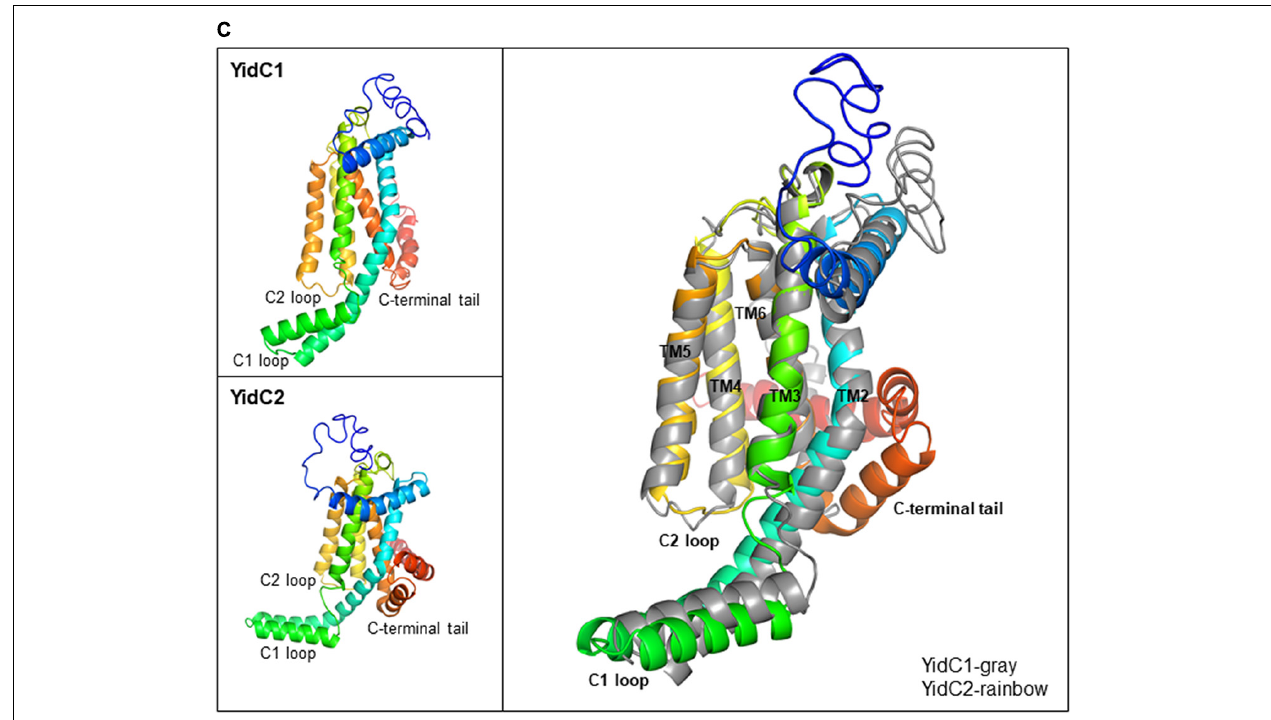
FIGURE 1 | In silico comparison of S. mutans YidC1 and YidC2. (A) Predicted membrane topologies of YidC1 and YidC2 using TM-Pred [TMpred Server (vital-it.ch)]. The mature YidC1 and YidC2 proteins each contain five TM domains and three cytoplasmic regions: C1 loop, C2 loop, and C-terminal tail. “ + + + ” or “ + + + + + ” refers to the relative positivity of the charged C-terminal tails of Sm YidC1 and YidC2. (B) Alignment of primary and secondary structures of SmYidC1 and SmYidC2 predicted by I-TASSER [I-TASSER server for protein structure and function prediction (umich.edu)]. Amino acid sequences were aligned using the Clustal Omega Program (EMBOSS-Needle) and presented using the ESPript2.2 program (Gouet et al., 1999). Identical residues are highlighted by red boxes, while similar residues are highlighted by red text. Indicated secondary structural helices are based on iTasser-predicted 3D structures. Green boxes correspond to transmembrane domains and yellow lines represent cytoplasmic domains. (C) Cartoon representations of the superimposed I-TASSER-predicted 3D structures of YidC1 and YidC2 with YidC1 shown in gray and YidC2 shown as rainbow colored from N- to C-terminus. The YidC2 structure superimposes on YidC1 with a root-mean-square deviation of 4.11 Å for all the C α atoms (for over 232